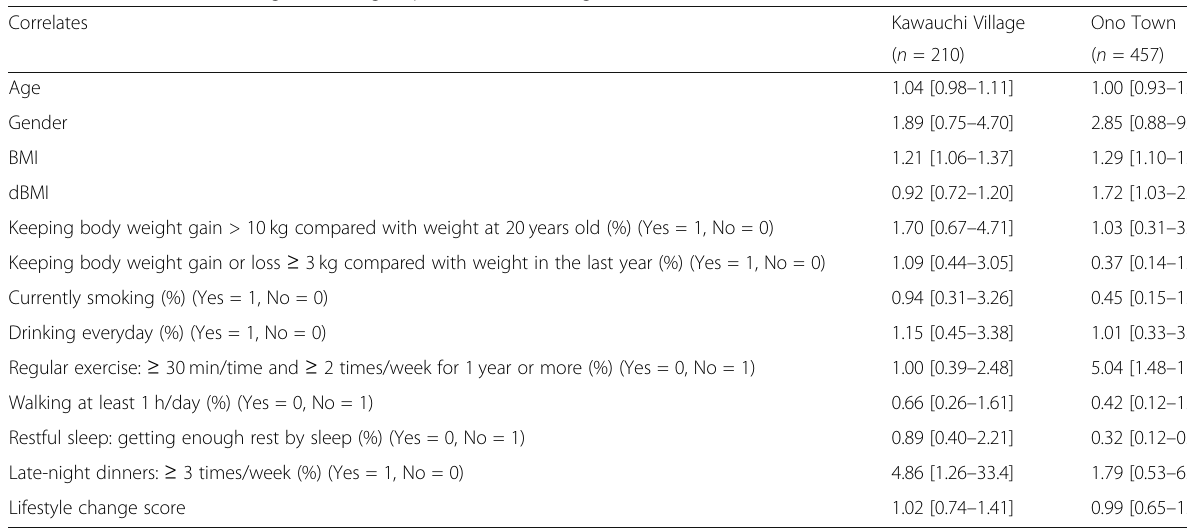
Table 4 Cox proportional hazard regression analyses to estimate the effect of lifestyle and BMI changes on the incidence of diabetes mellitus (DM) among non-DM group in Kawauchi village (with evacuation) and Ono town (without evacuation)